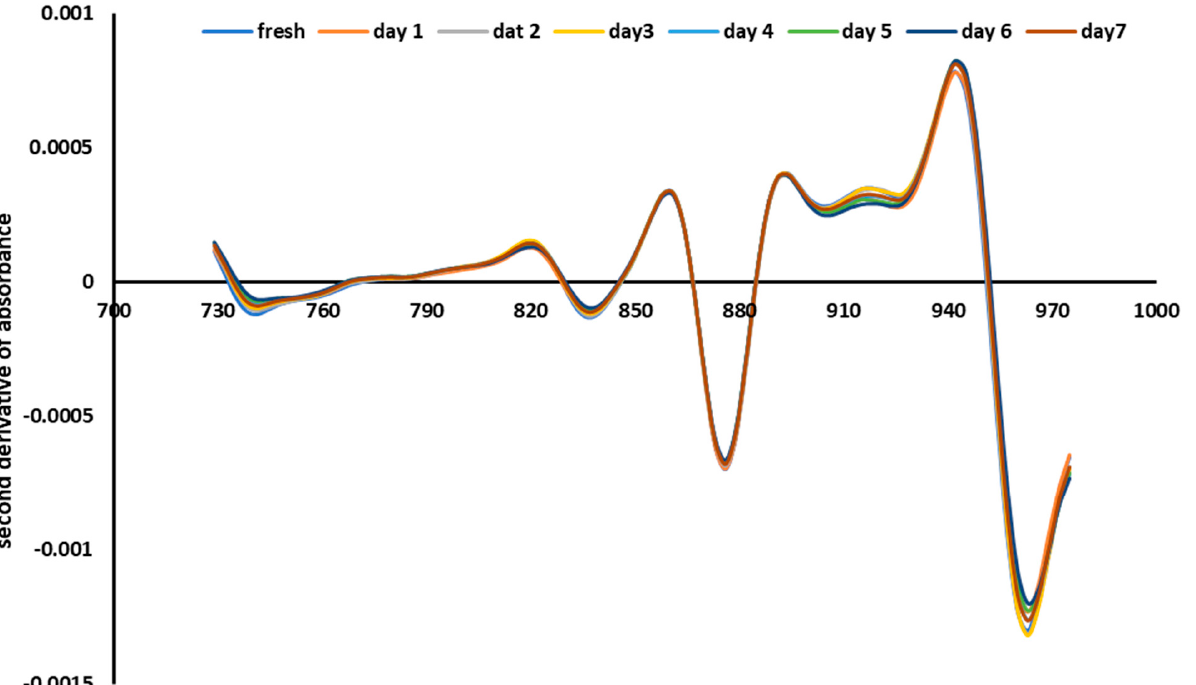
Figure 2. The mean second derivative of absorbance in the wavelength range (729–975 nm) for the shelf-life period of the stored laban drink.